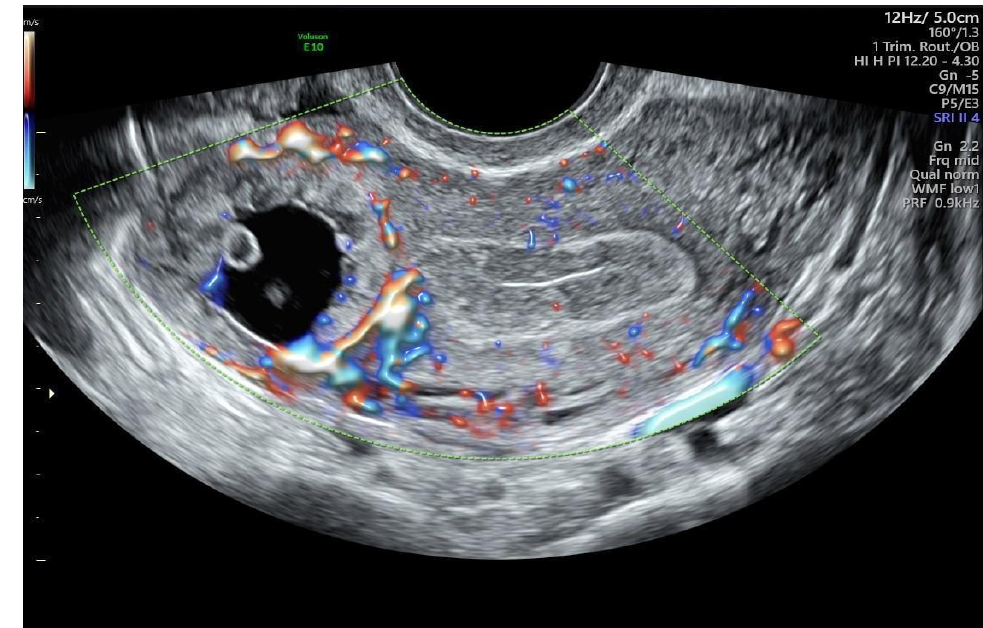
Figure 1. Transvaginal ultrasound finding of interstitial pregnancy.